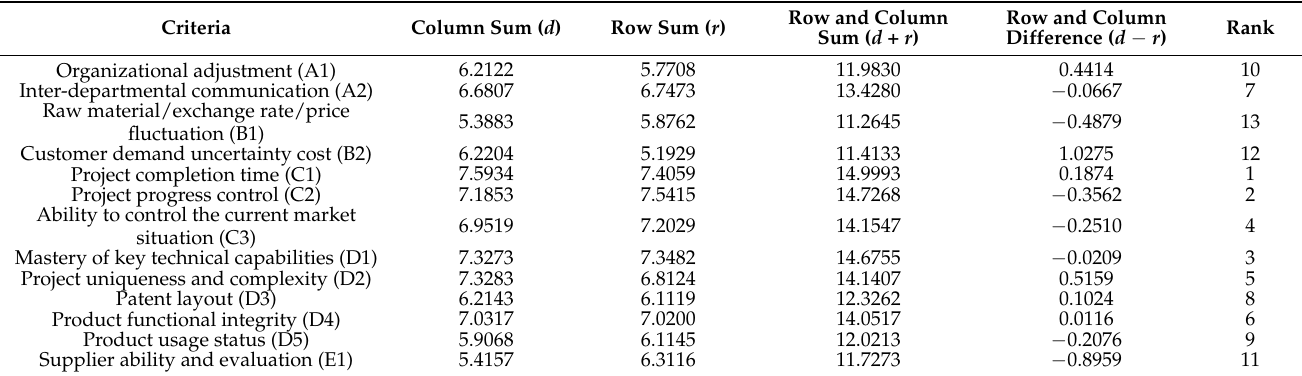
Table 7. Importance and relevance of corresponding